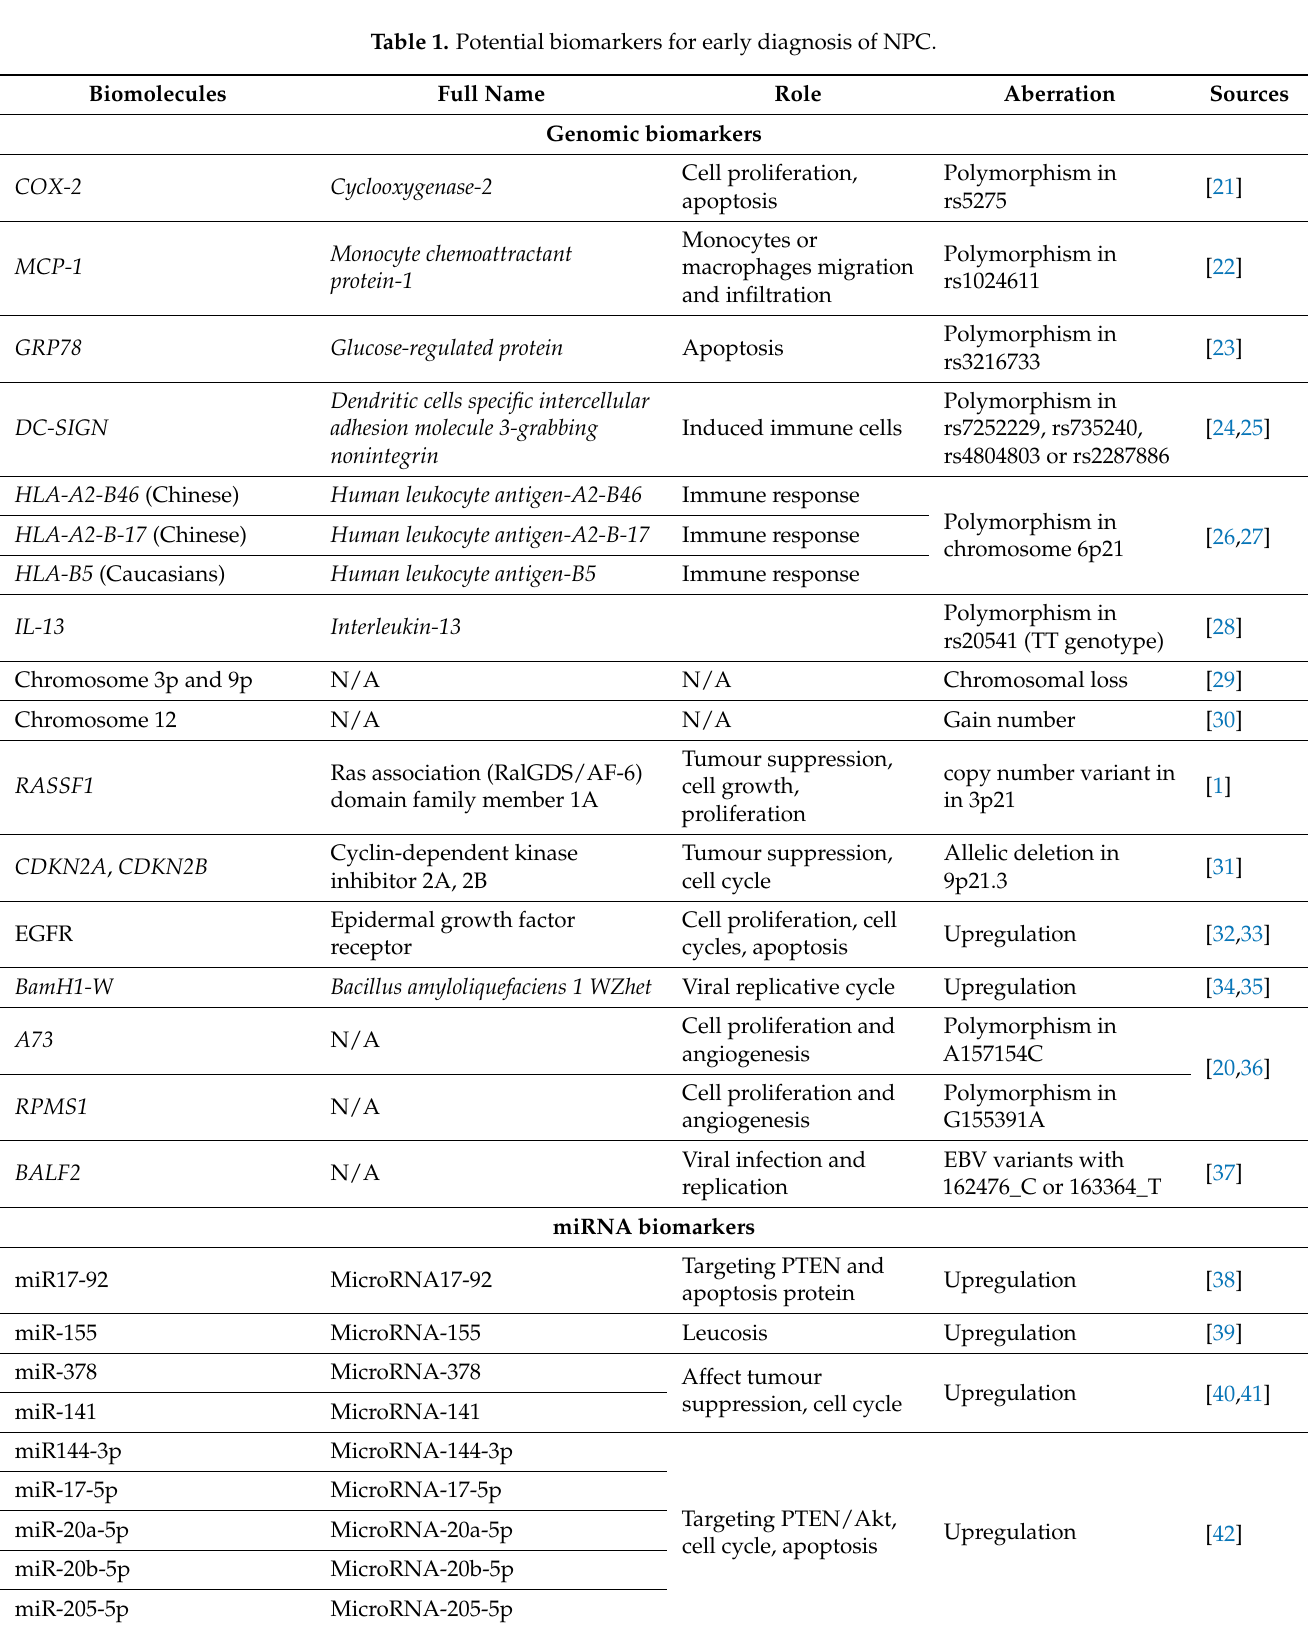
Table 1. Potential biomarkers for early diagnosis of